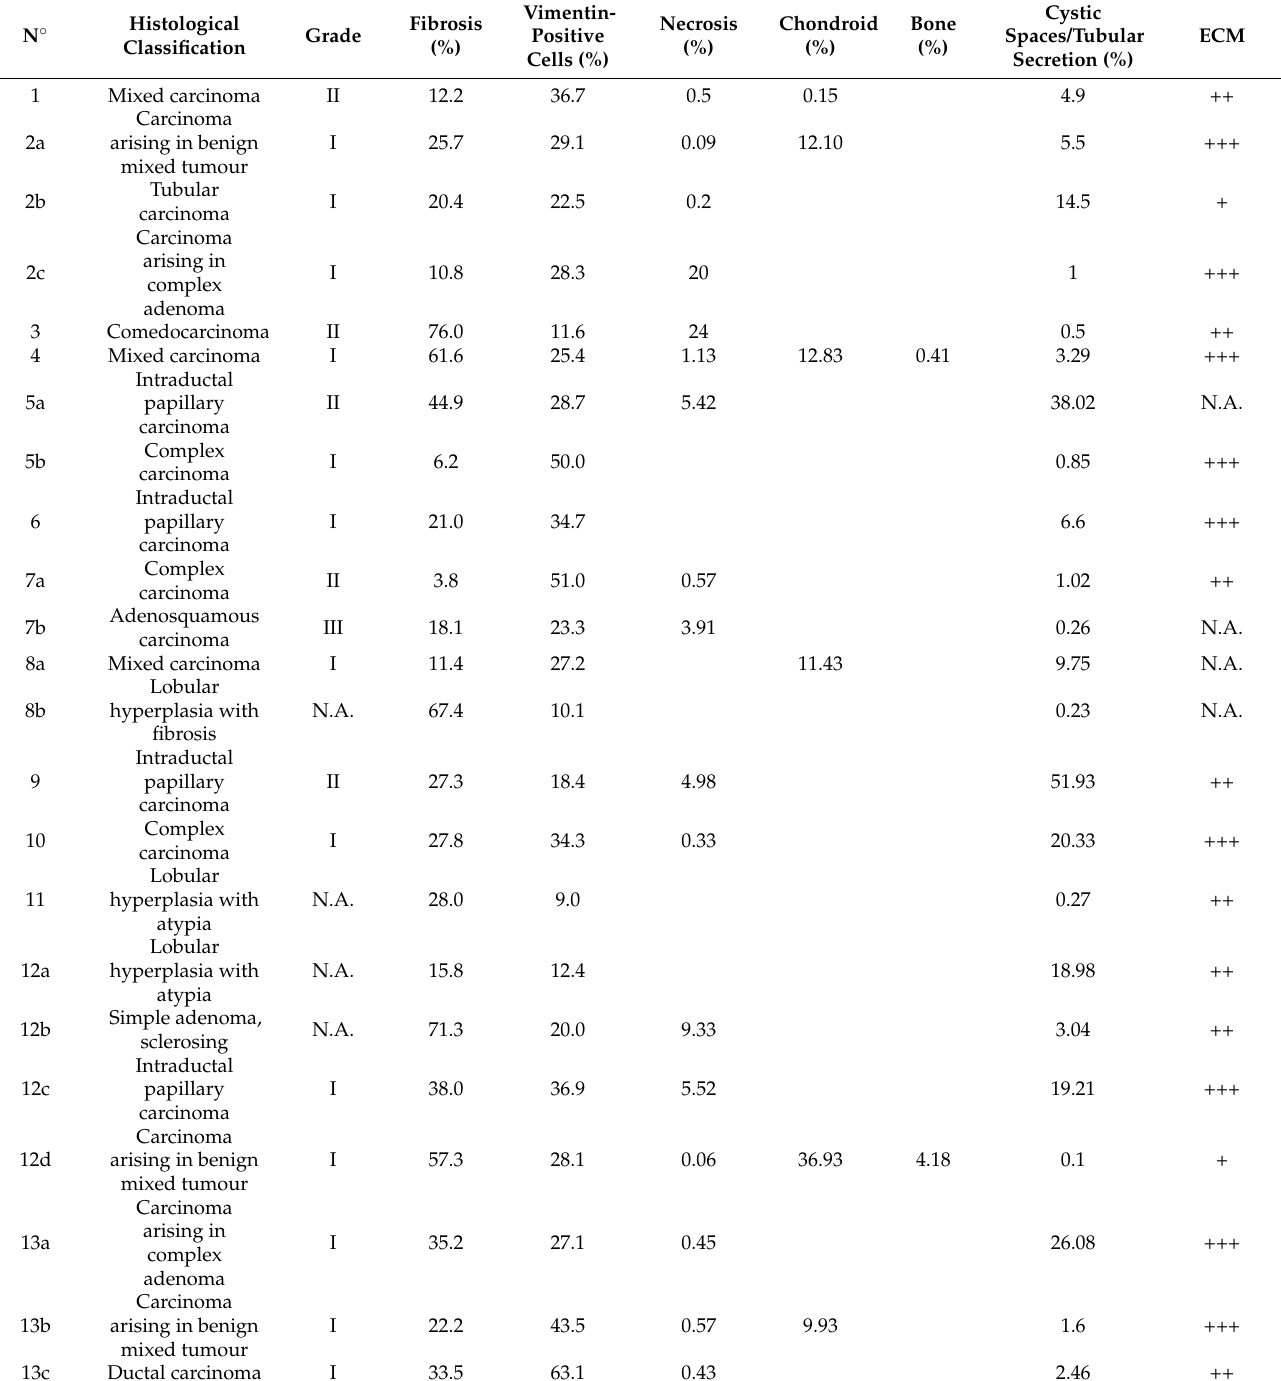
Table 2. Classification and histological features of the canine mammary gland nodular lesions included in the